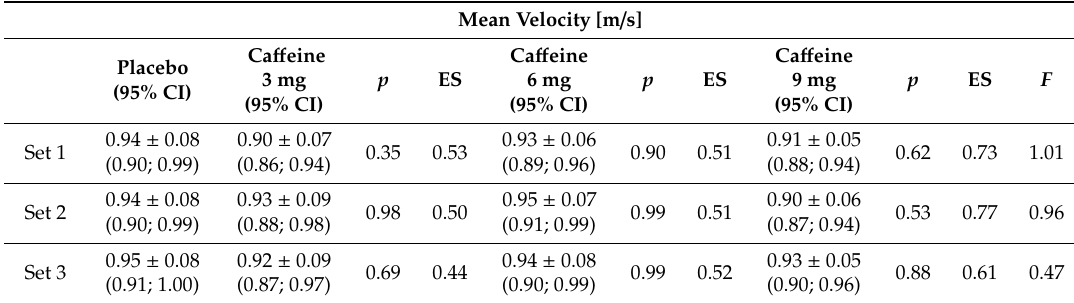
Table 3. Results of mean velocity in three successive sets of the bench press exercise in the group that ingested di ff erent doses of ca ff eine, and the placebo group.